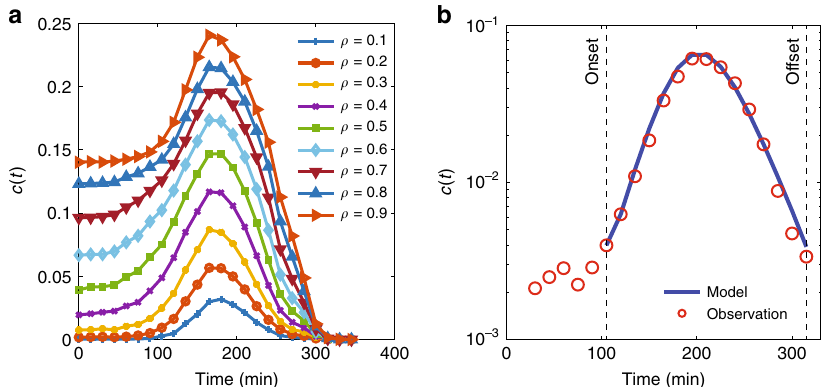
Fig. 4 Propagation and dissipation of congestion in Melbourne network. a Evolution of fraction of congested links in the network over time for various ρ subject to realistic and calibrated 4-h demand followed by a 4-h recovery period with zero demand starting at t = 240 min. b Fitted SIR model to dynamics of the system with estimated parameters β = 0.0577 and μ = 0.0812 when ρ = 0.2 and k = 2.12. Data are obtained from the simulation-based DTA model. The vertical axis associated with c ( t ) is scaled logarithmically.